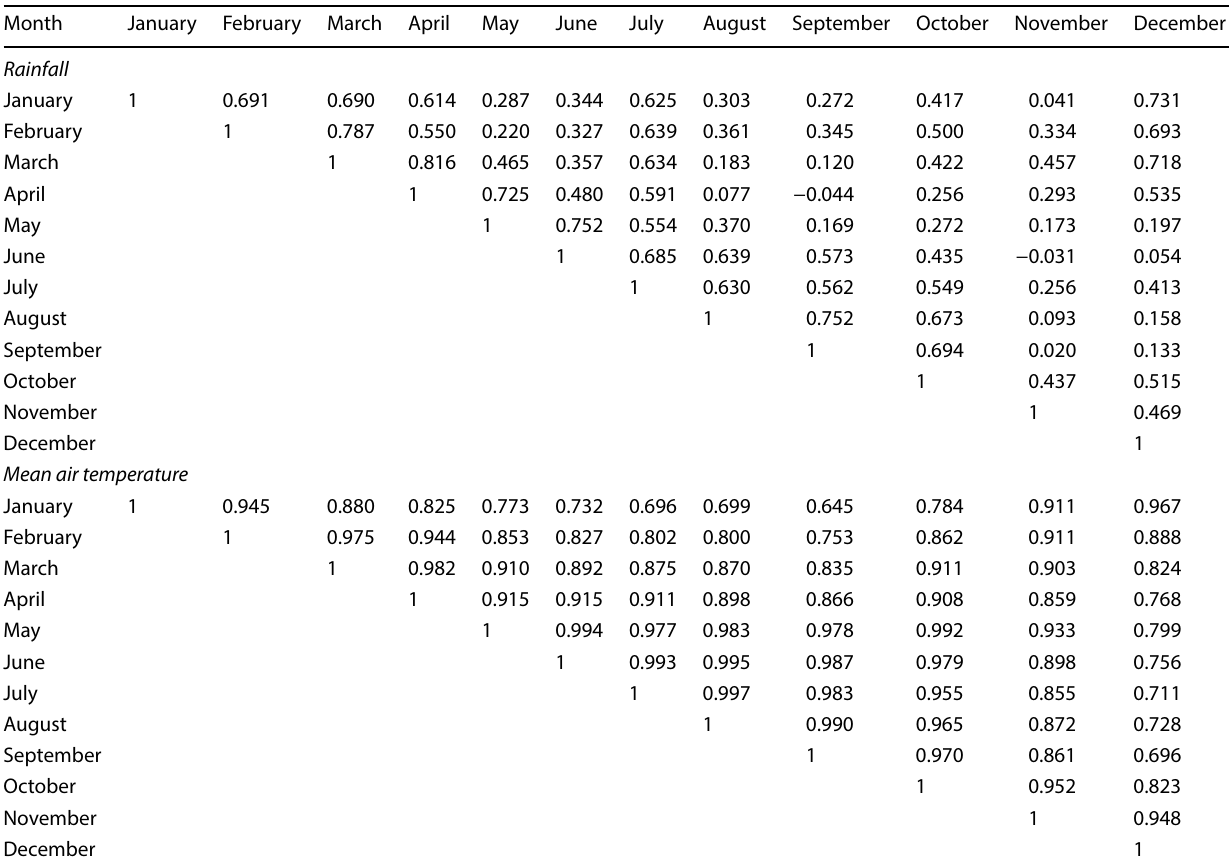
Table 2 Pearson linear correlation